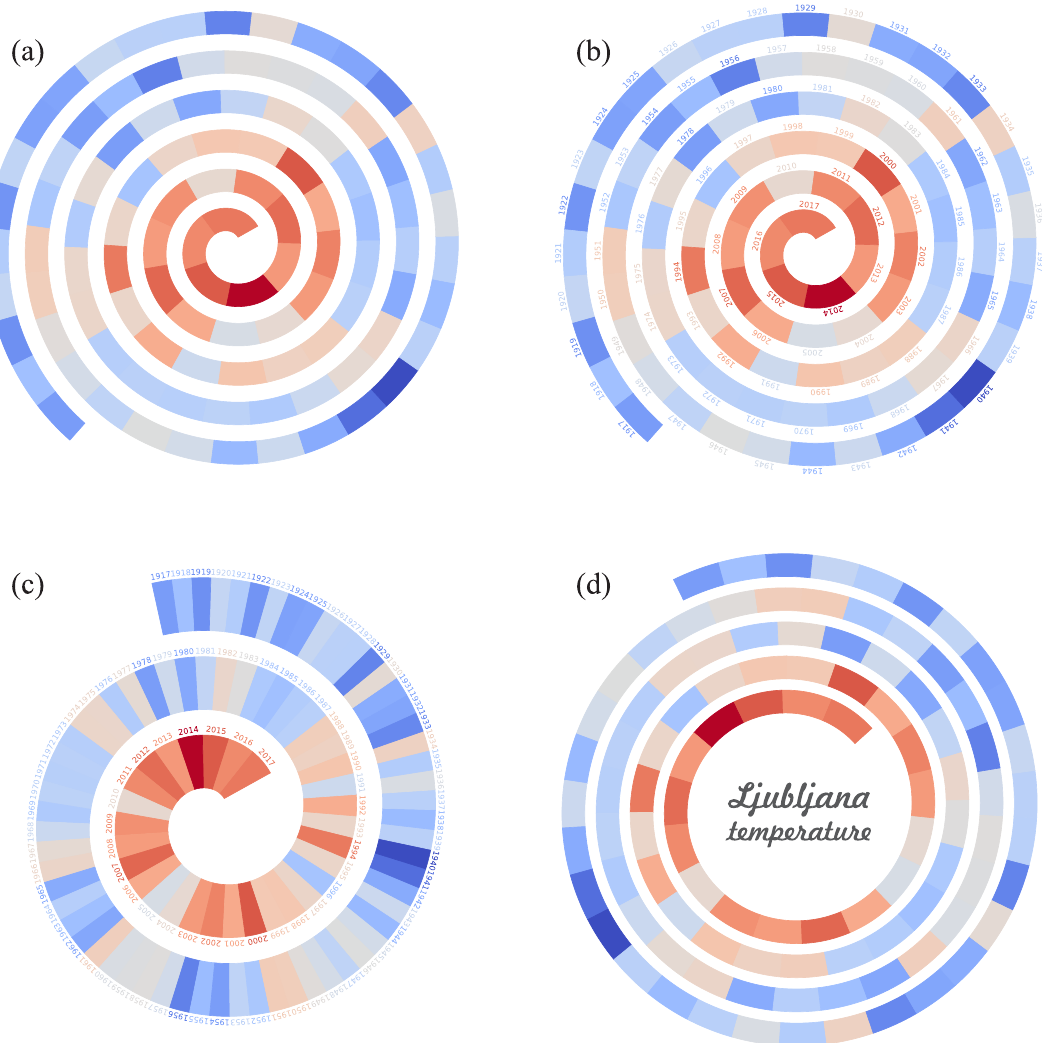
Figure 2. Four spiral strips all showing a hundred years of average yearly 2-m temperatures in Ljubljana in the period of 1917–2017. The colder years are represented in more bluish colors, and the warmer in more reddish. The time in all strips increases towards the center of the spiral. ( a ) shows a rather thin spiral strip that makes approximately five and a half loops around the center. ( b ) is identical to ( a ), except that labels were added near each segment indicating the year. ( c ) shows a strip with wider and shorter segments. ( d ) is similar to ( a ), except with the spiral strip starting some way off the center, and a label was added. For a more detailed description and discussion of examples, please refer to the